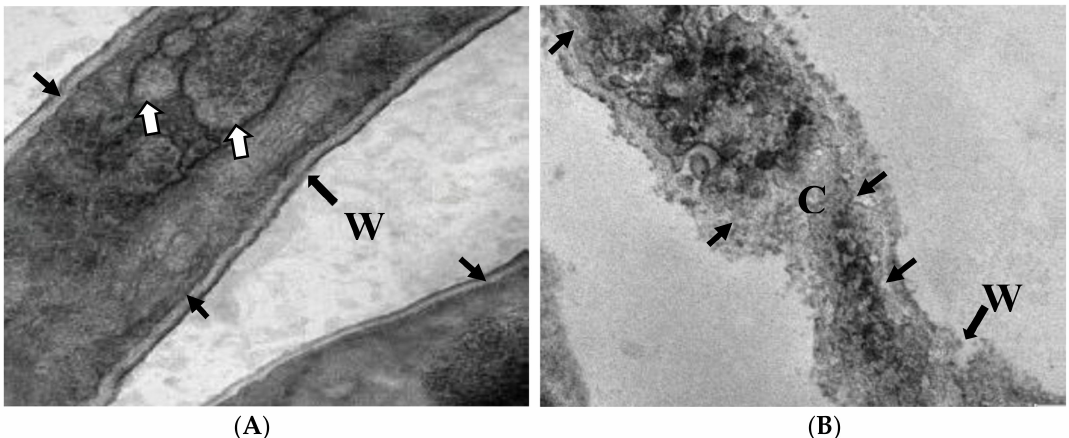
Figure 13. TEM studies of a longitudinal section of A. solani hypha. ( A ). Normal untreated hypha showing typical cell wall (W), cell membrane (arrow) and organelles (short arrows). ( B ). Hyphae treated with AgNPs (100 µ g/mL) biosynthesized from pomegranate peel extract showing disintegration and deterioration of cytoplasm (CY), break down of the cell membrane (arrow) and cell wall (W) and collapse of hyphae. Scale bar = 0.5 µ